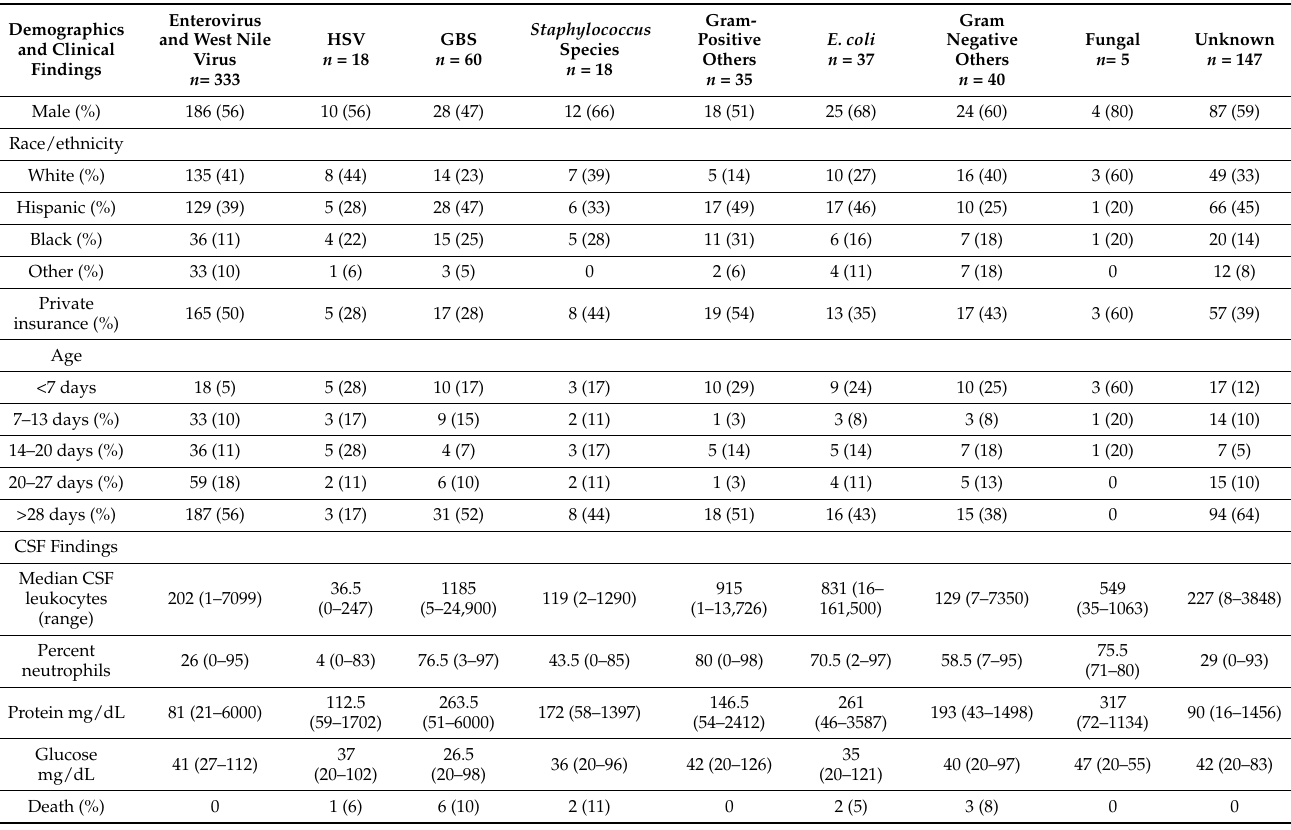
Figure 2. Enteroviral meningitis by year.